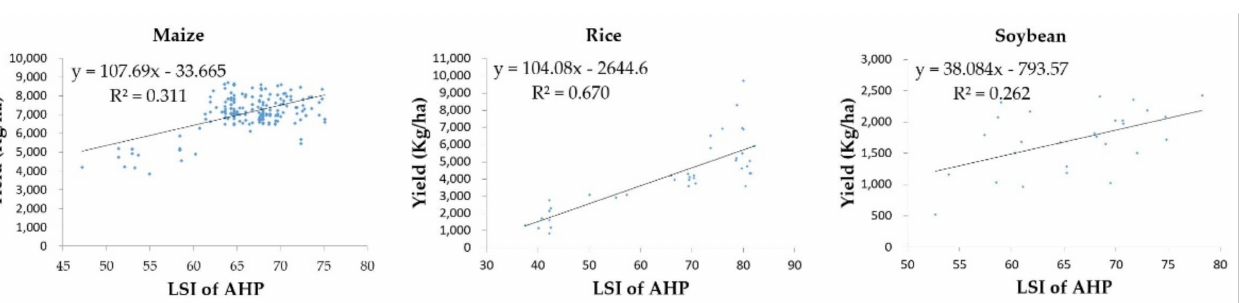
Figure 8. Linear regression between LSI data for the AHP model along with yield (kg/ha).